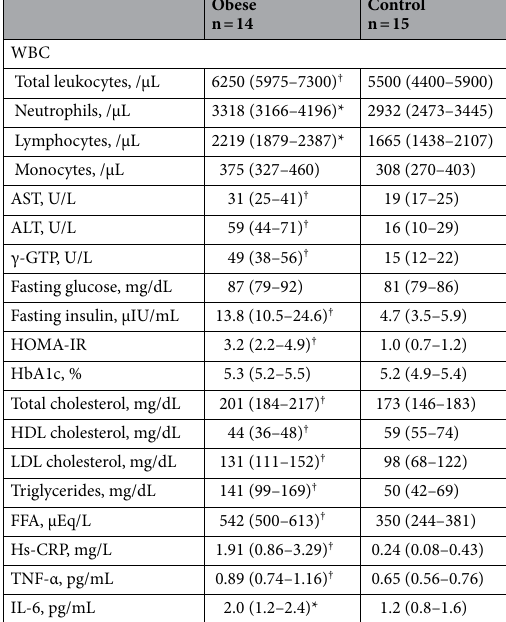
Table 2. Laboratory data. Values are median (IQR). ALT alanine aminotransferase, AST aspartate transaminase, BMI body mass index, FFA free fatty acids, HbA1c hemoglobin A1c, HDL high-density lipoprotein, HOMA-IR homeostasis model assessment of insulin resistance, hs-CRP high-sensitive C-reactive protein, IL-6 interleukin-6, LDL low-density lipoprotein, TNF-α tumor necrosis factor-alpha, WBC white blood cell, γ-GTP gamma-glutamyl transpeptidase. * P < 0.05 and † P < 0.01 vs.